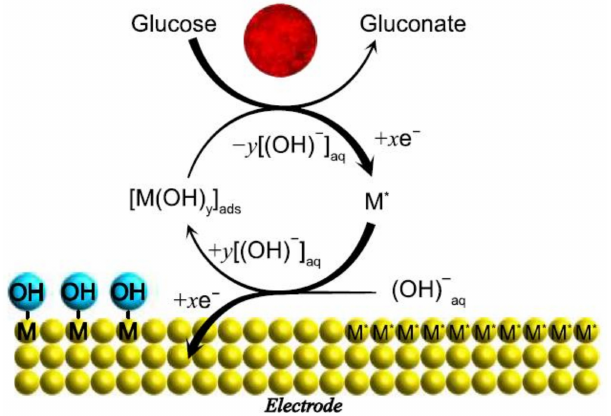
Figure 5. Illustration of the glucose-electrode according to incipient hydrous adatom mediator (IHOAM)